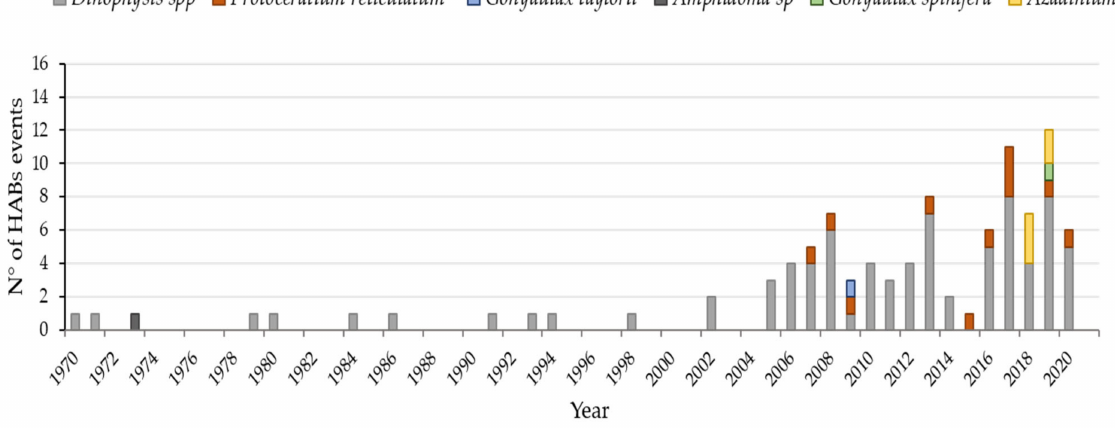
Figure 9. Distribution of HABs events per year associated with lipophilic toxins in Chile.